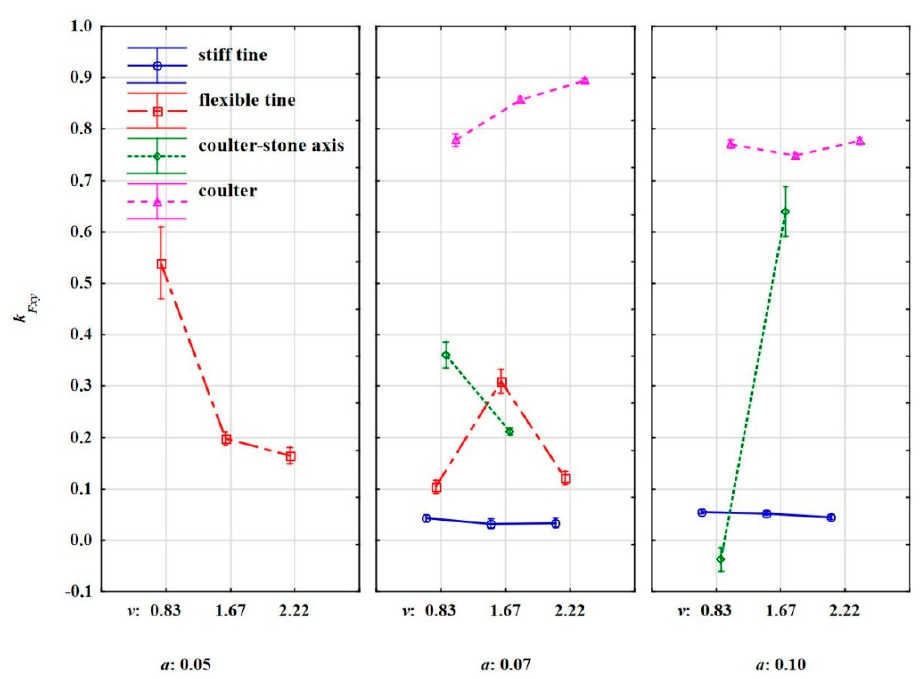
Figure 14. The directional coefficient of the specific force resultant in the horizontal plane k Fxy as a reaction when the elements collide with stone: stiff tine, flexible tine, coulter-axis stones and coulter working at varied depths and working speeds.